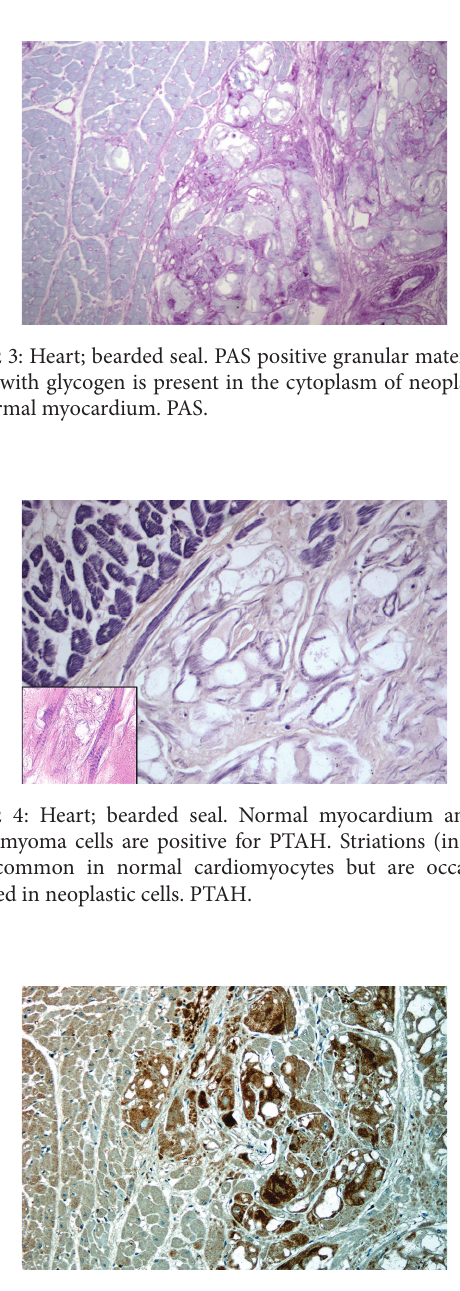
Figure 5: Heart; bearded seal. Neoplastic cells are moderately immunoreactive for protein gene product 9.5.